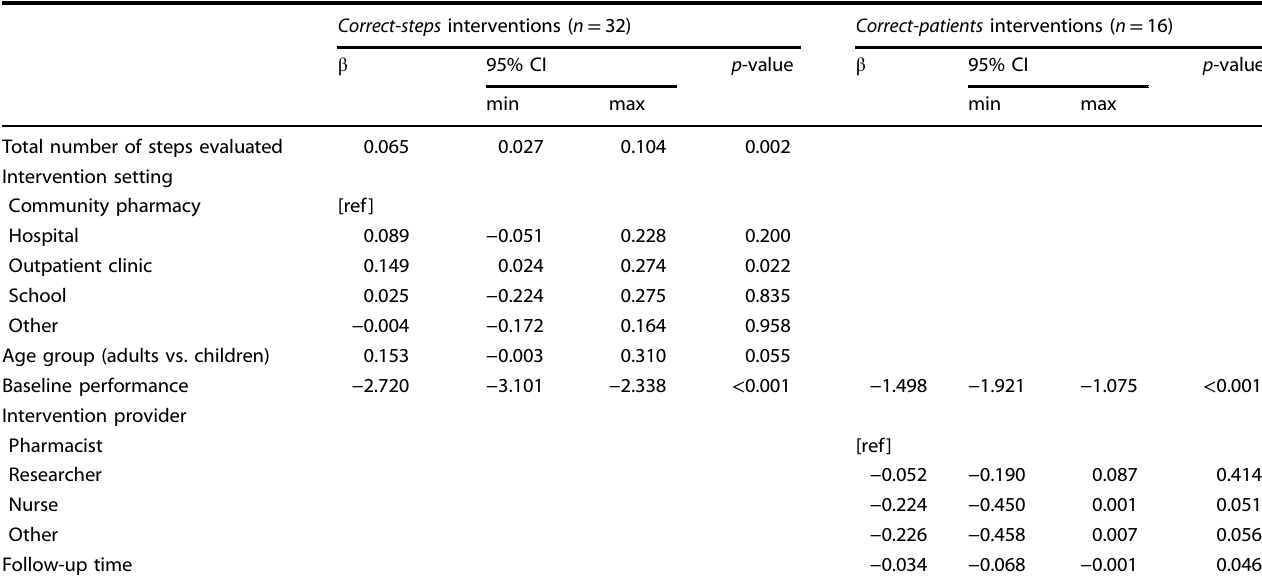
Table 2. Linear regression models with improvement over baseline as dependent